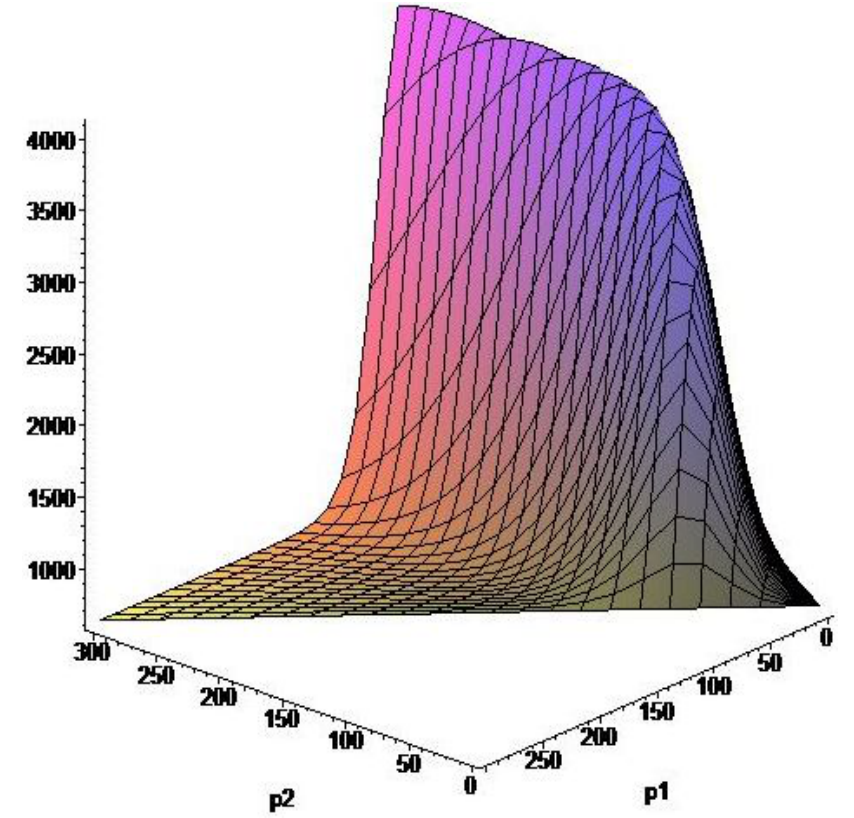
Figure 9. Surface (cid:101) J ( θ ) for the Ebola outbreak in Liberia (2014) for σ = 0 . 01 , ν = 0 . 01